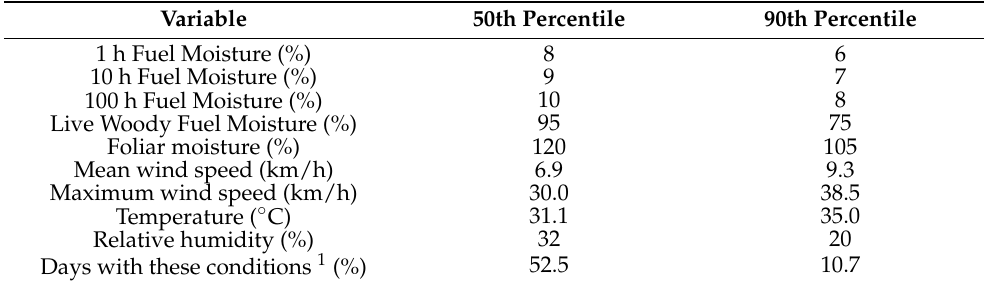
Table A1. Weather and fuel moisture conditions used in fire behavior simulations, related to 50th and 90th percentiles of temperature, relative humidity and wind